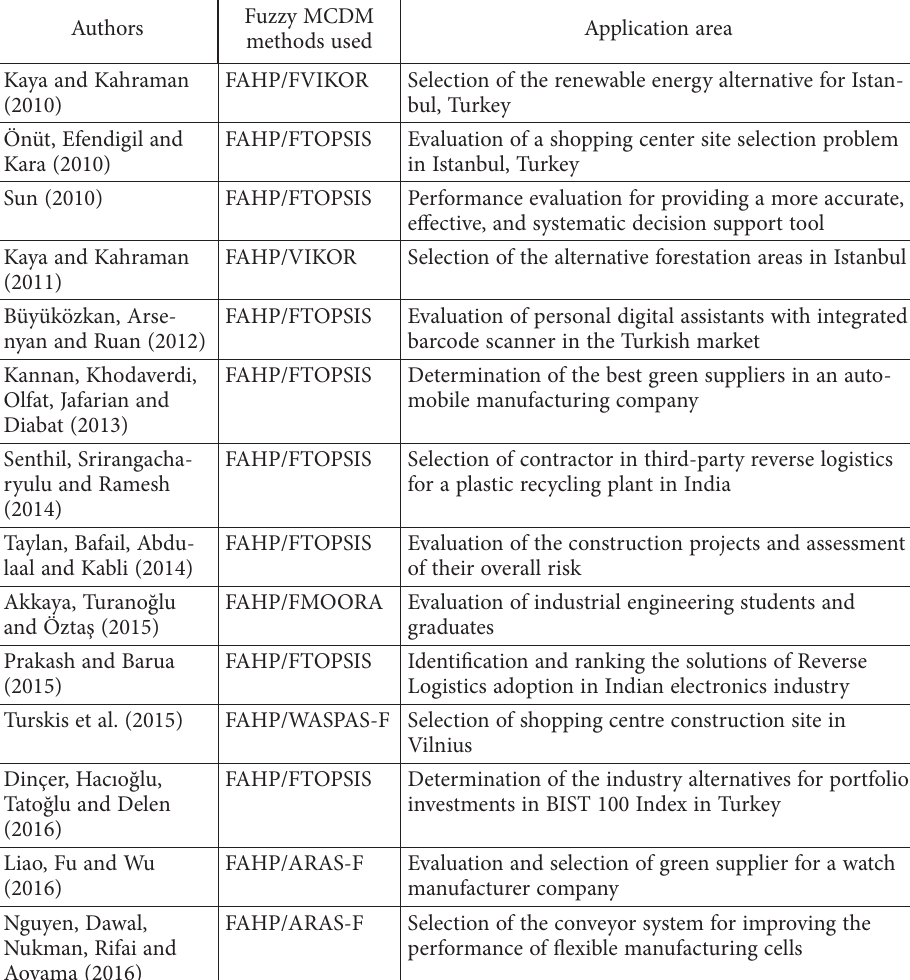
Table 1. Some of the literature summary on integrated FMCDM methods for various application